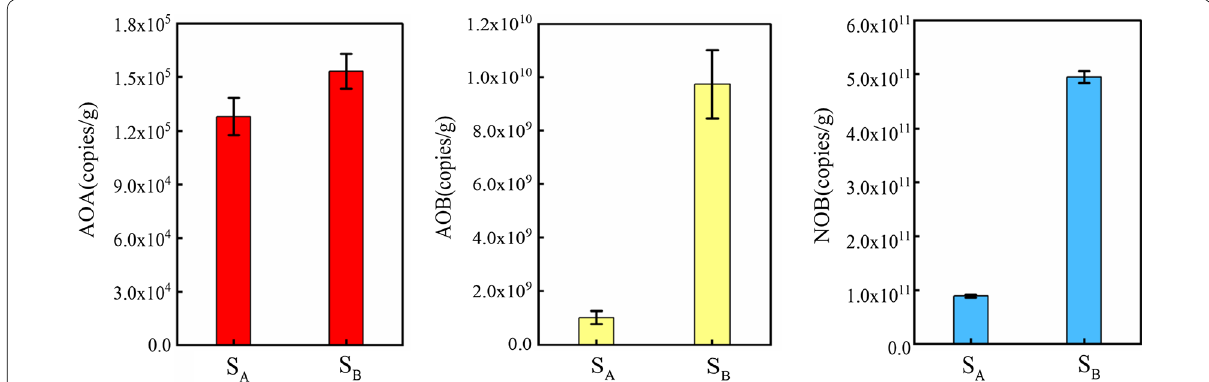
Fig. 4 Abundances of AOA, AOB and NOB in the aeration tank of Xinfeng WWTPs